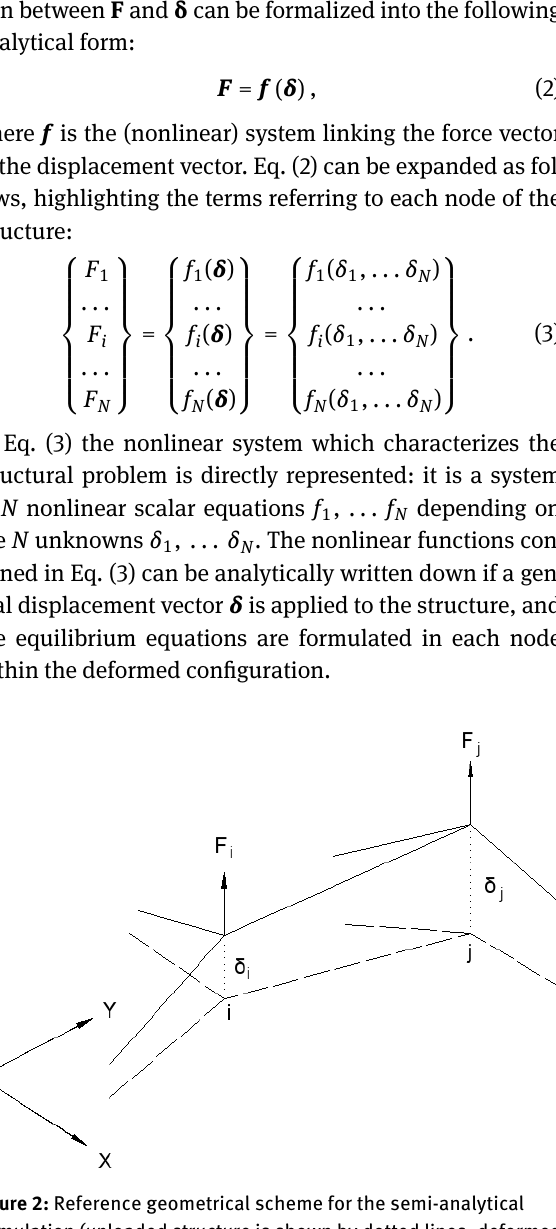
The vector δ being applied to the structure, the i th and j th nodes undergo vertical displacements δ i and δ j respec- tively (Figure 2). The bar connecting the i th and j th